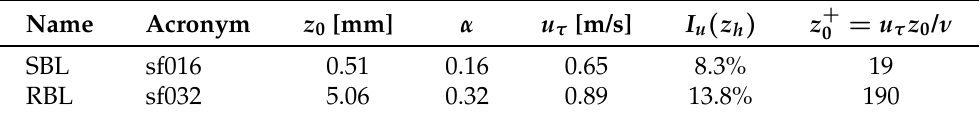
Table 1. Characteristics of the turbulent boundary layers in the reference experiment